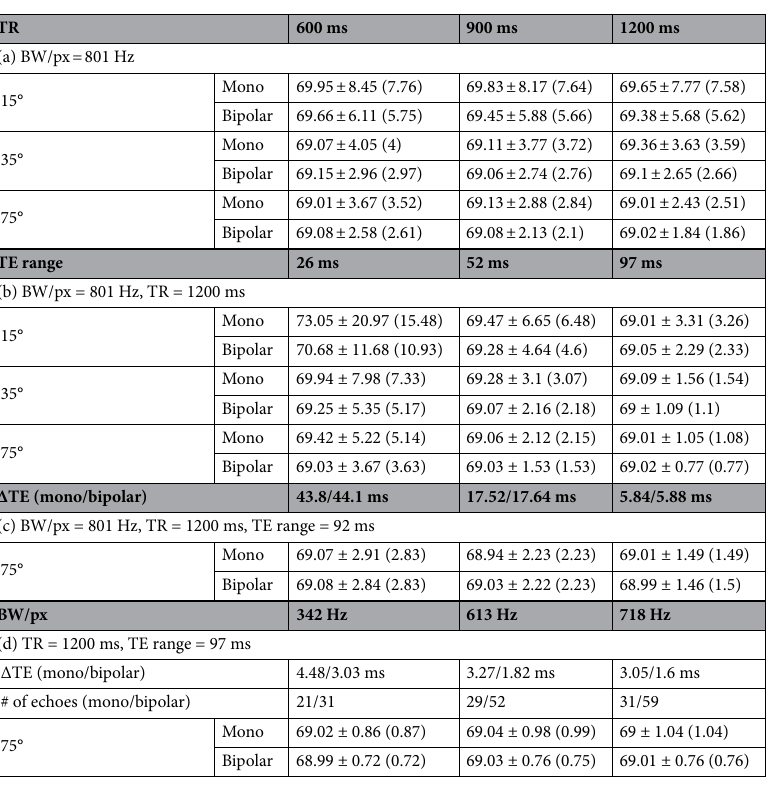
Table 1. Mean and standard deviation of the calculated T2*s in the computer simulation with respect to the (a) α and TR (b) α and TE range (c) ∆TE and (d) BW/px. The values were measured in ROI 3 (Fig. 1a). The number in the parentheses shows the predicted standard deviation using a CRLB. As with the visual observation, standard deviation increases as the α, TR, and the TE range decrease. (a and b) The difference between the two readouts becomes larger for a lower SNR and shorter TE range. (c) The ‘std diff’ is substantially smaller when the ∆TEs from each readout are similar. (d) By decreasing the BW, the bipolar readout can achieve the same number of echoes as the monopolar readout but with higher precision. When the BW/px of monopolar and bipolar readouts are 718 Hz and 342 Hz, respectively, both readouts acquire 32 echoes. However, bipolar readouts provide a smaller standard deviation (i.e., 0.72 ms) compared to monopolar readouts (i.e., 1.04